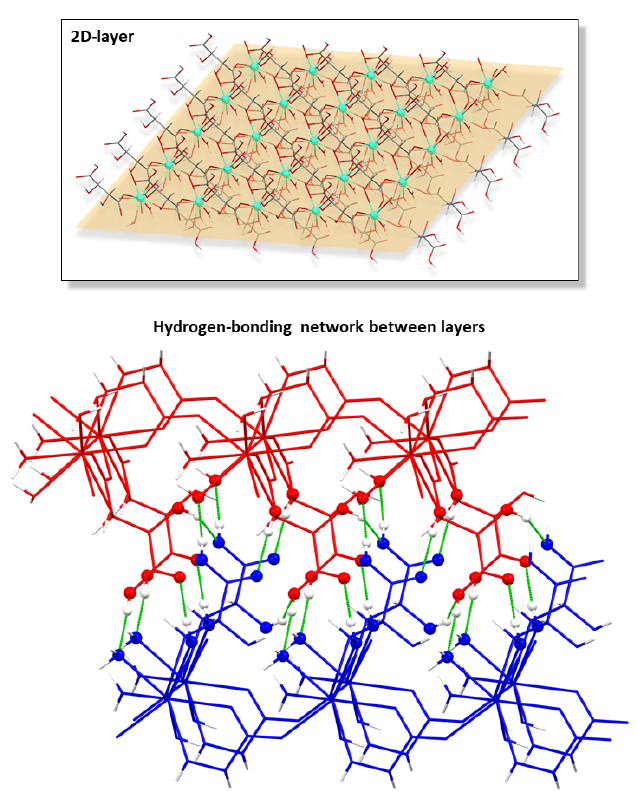
Figure 2. Chiral two-dimensional layer of 2D_Gd-L MOFs and the hydrogen bonding scheme of interconnected layers.